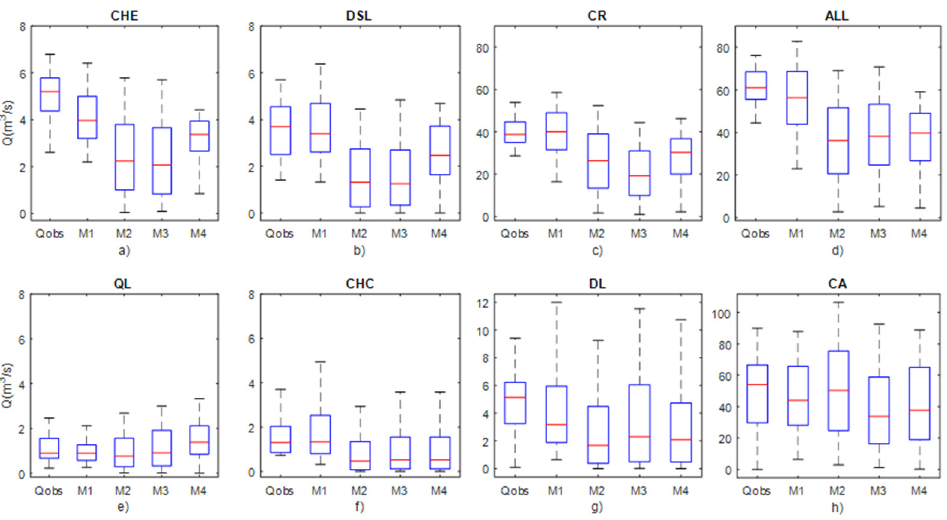
Figure 5. Boxplots of observed and simulated low flows (Q 70 ).